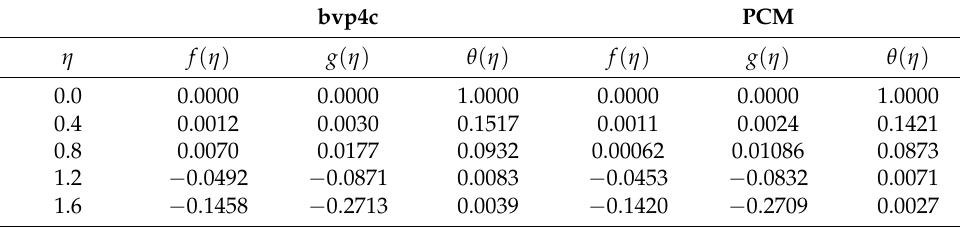
Table 3. Comparative analysis between the bvp4c and PCM